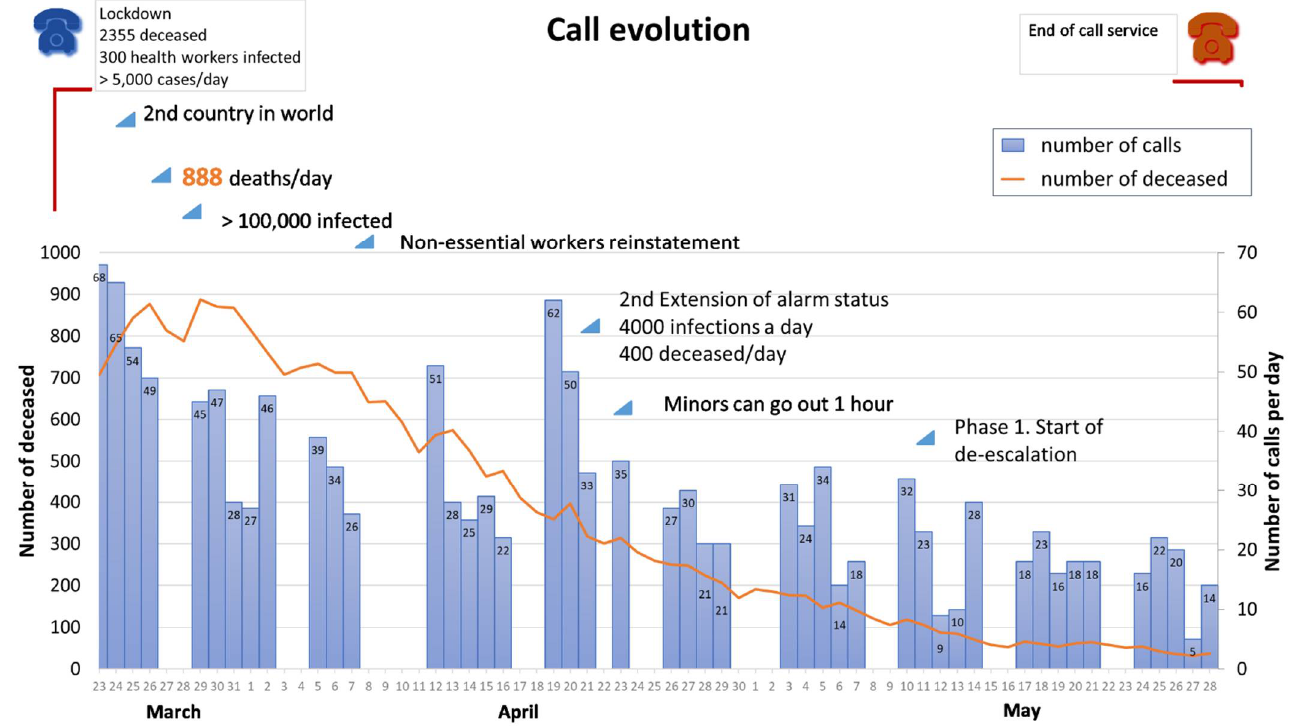
Figure 1. Evolution of the number of calls and deaths according to the main milestones of the pan- demic.